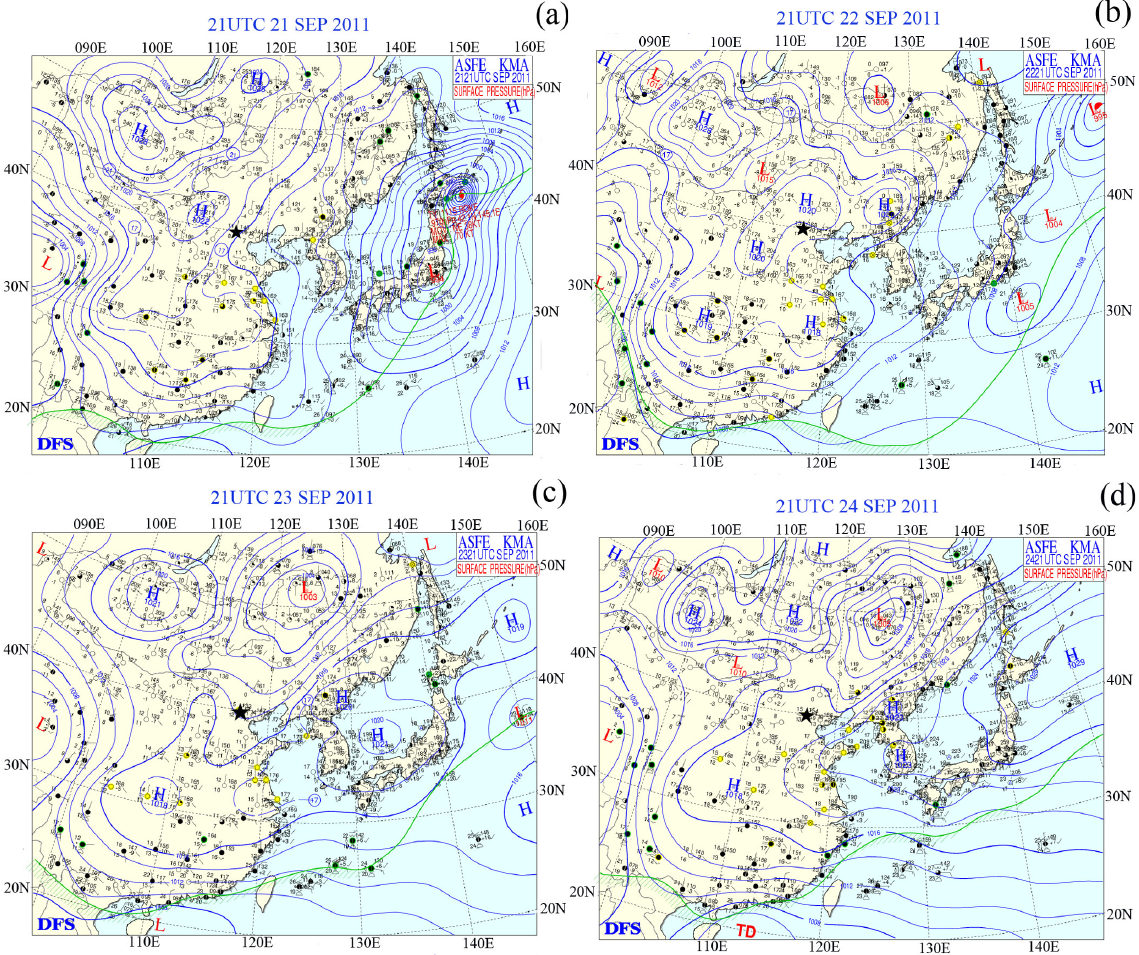
Fig. 4. Weather maps on the surface at (a) 05:00LT 22 September, (b) 05:00LT 23 September, (c) 05:00LT 24 September, and (d) 05:00LT 25 September. Black star denotes measurement